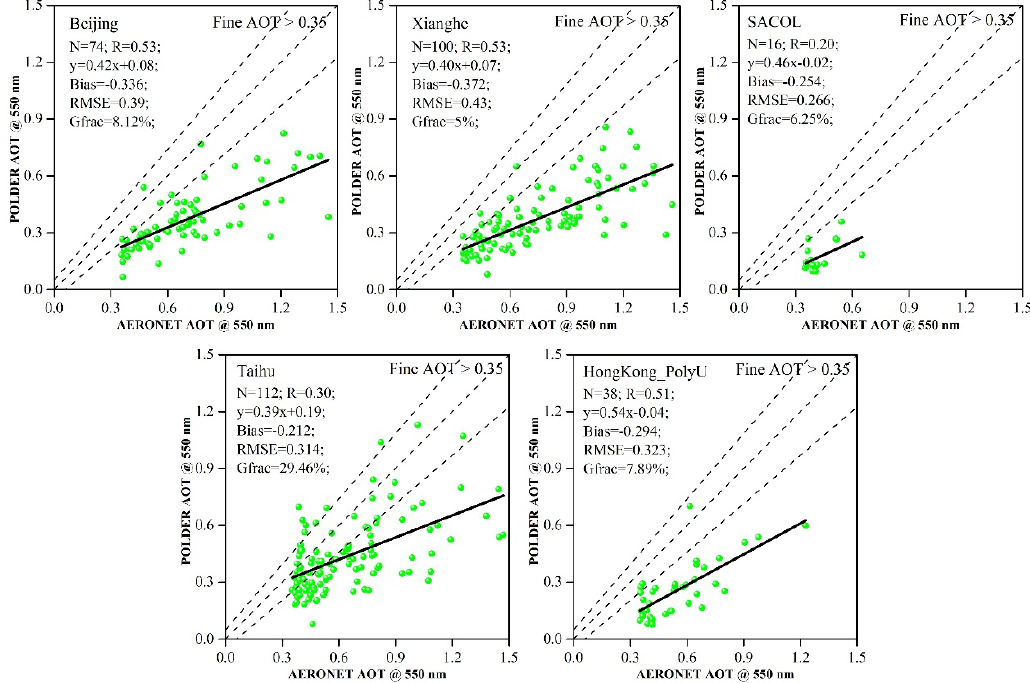
Figure 8. Scatter plots for POLDER fine-AOTs for high aerosol loading days at the five AERONER sites of